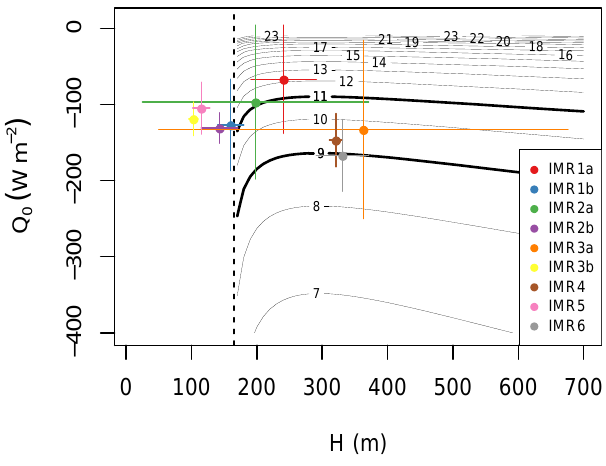
Figure B1. Residency time in the euphotic layer ( T eu ) as a function of the ML depth ( H ) and the surface heat flux ( Q 0 ) at the onset time of the bloom. The estimates are based on Eq. (B5) with the following parameter values: A = 0 . 45, c P = 3984J(kg ◦ C) − 1 , α = 1 . 22 × 10 − 4 ◦ C − 1 , g = 9 . 81m 2 s − 1 , ρ 0 = 1028kgm − 3 , ( c P ,α and ρ 0 are the average values at the nine bloom onsets). The vertical dashed line is the euphotic depth, H eu = 165m. The dots represent the ML depth and surface heat flux at bloom onset for all floats. The estimates for Q 0 , H and their uncertainties are discussed in the